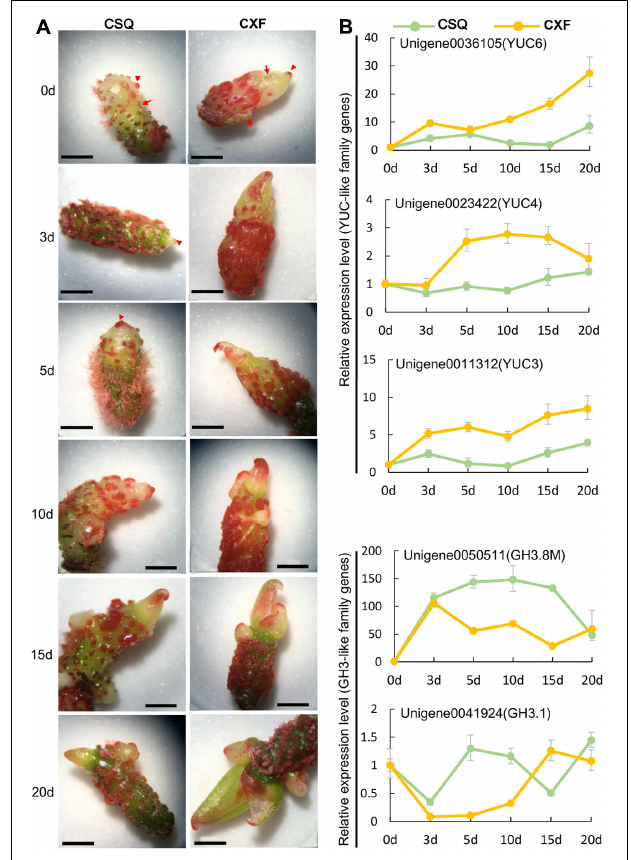
FIGURE 5 | Time course of morphological structure and auxin-related gene expression during shoot regeneration of rhizomes in Cymbidium . (A) Morphological structure of CXF and CSQ cultured on SIM for 0, 3, 5, 10, 15, and 20 days. Arrowheads indicate the top of rhizomes, while arrows indicate the sheath leaves. (B) Time course expression analysis of YUC-like and GH3-like unigenes. The expression relative quantity at 3, 5, 10, 15, and 20 days was normalized to an expression level of 0 day. Bar = 10